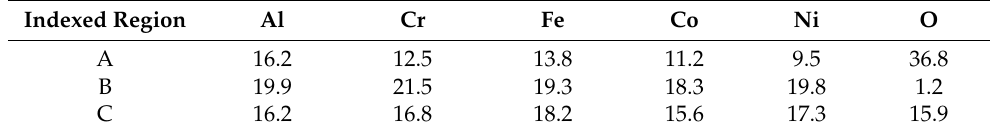
Table 4. The localized elemental percentage (wt.%) obtained by the EDS results for the selected regions marked in the oxidized micro- and nanocrystalline coatings (indexed in Figure 9a,b). Indexed